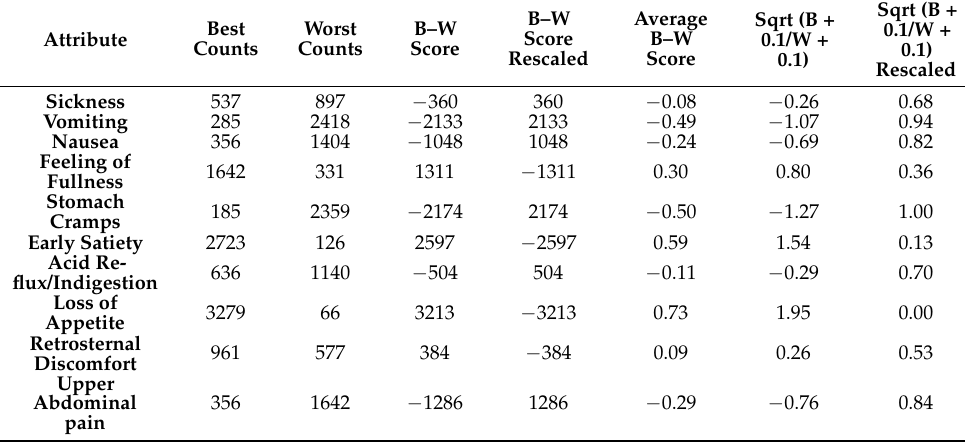
Table 4. Results of the BWS count